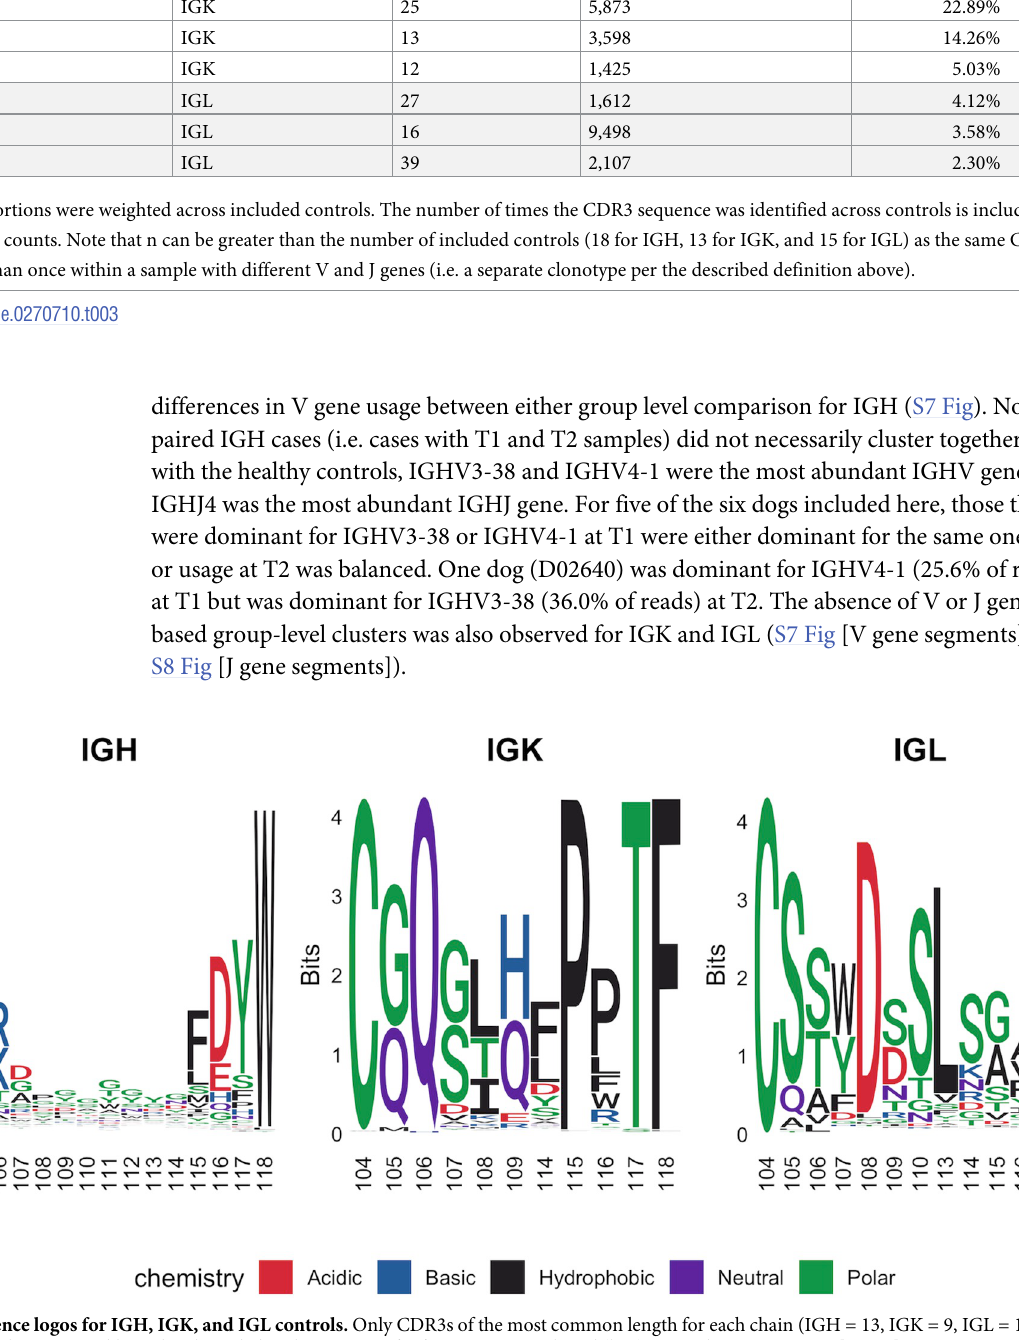
Fig 10. Sequence logos for IGH, IGK, and IGL controls. Only CDR3s of the most common length for each chain (IGH = 13, IGK = 9, IGL = 11) were considered with amino acid letter height scaled to the amount of information contributed (bits) using Shannon entropy